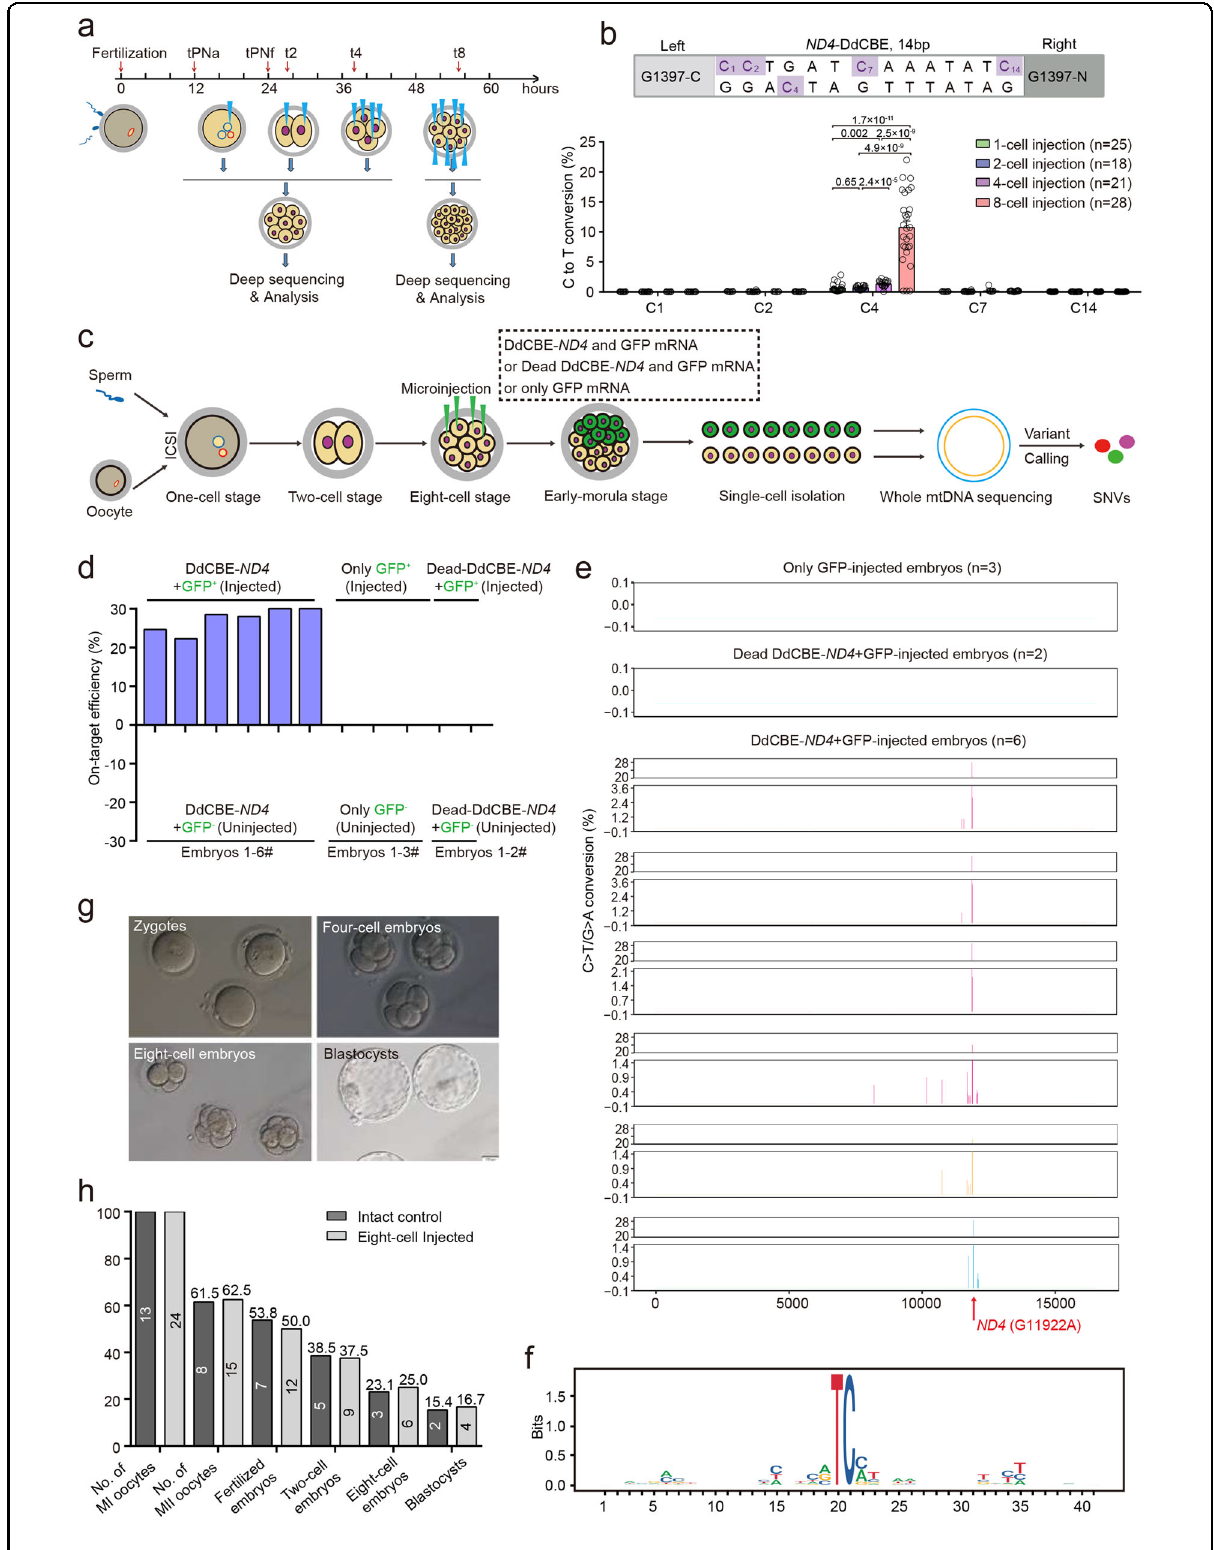
Fig. 1 (See legend on next